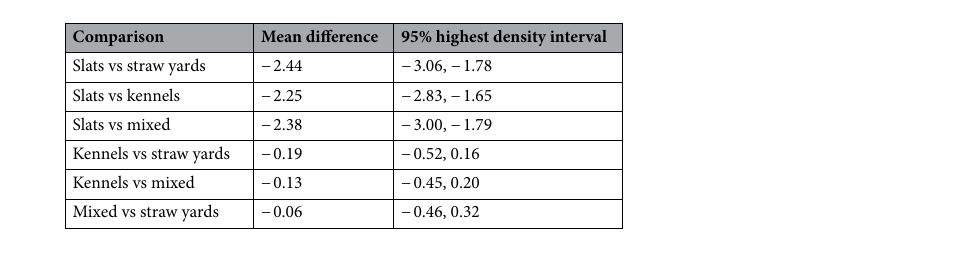
Table 4. Summary of comparisons of the effect of housing type on the backfat (P2) scores of batches of pigs.